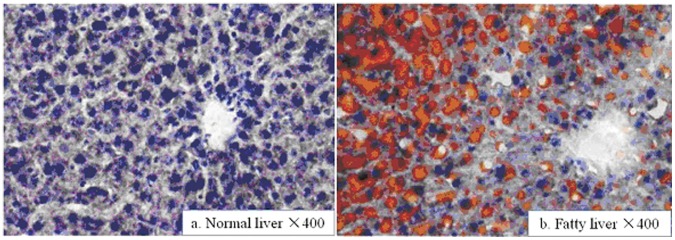
Difference of steatosis in the livers of fatty vs. normal Sprague-Dawley(SD) rats using hematoxylin-eosin(HE) staining.(a) Normal SD rats show no evidence of steatosis. (b) Fatty SD rats show fatty infiltration in hepatocytes. Hematoxylin-eosin(HE) staining; original magnification ×400.